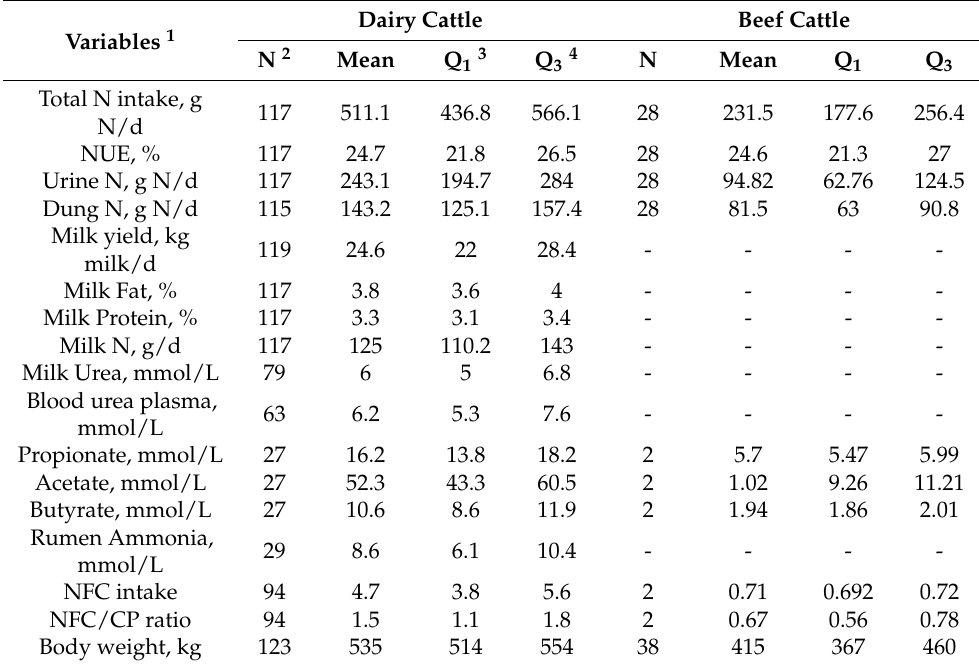
Table 3. Summary of reported variables on nitrogen intake and its partitioning into products, urine and dung of Chilean